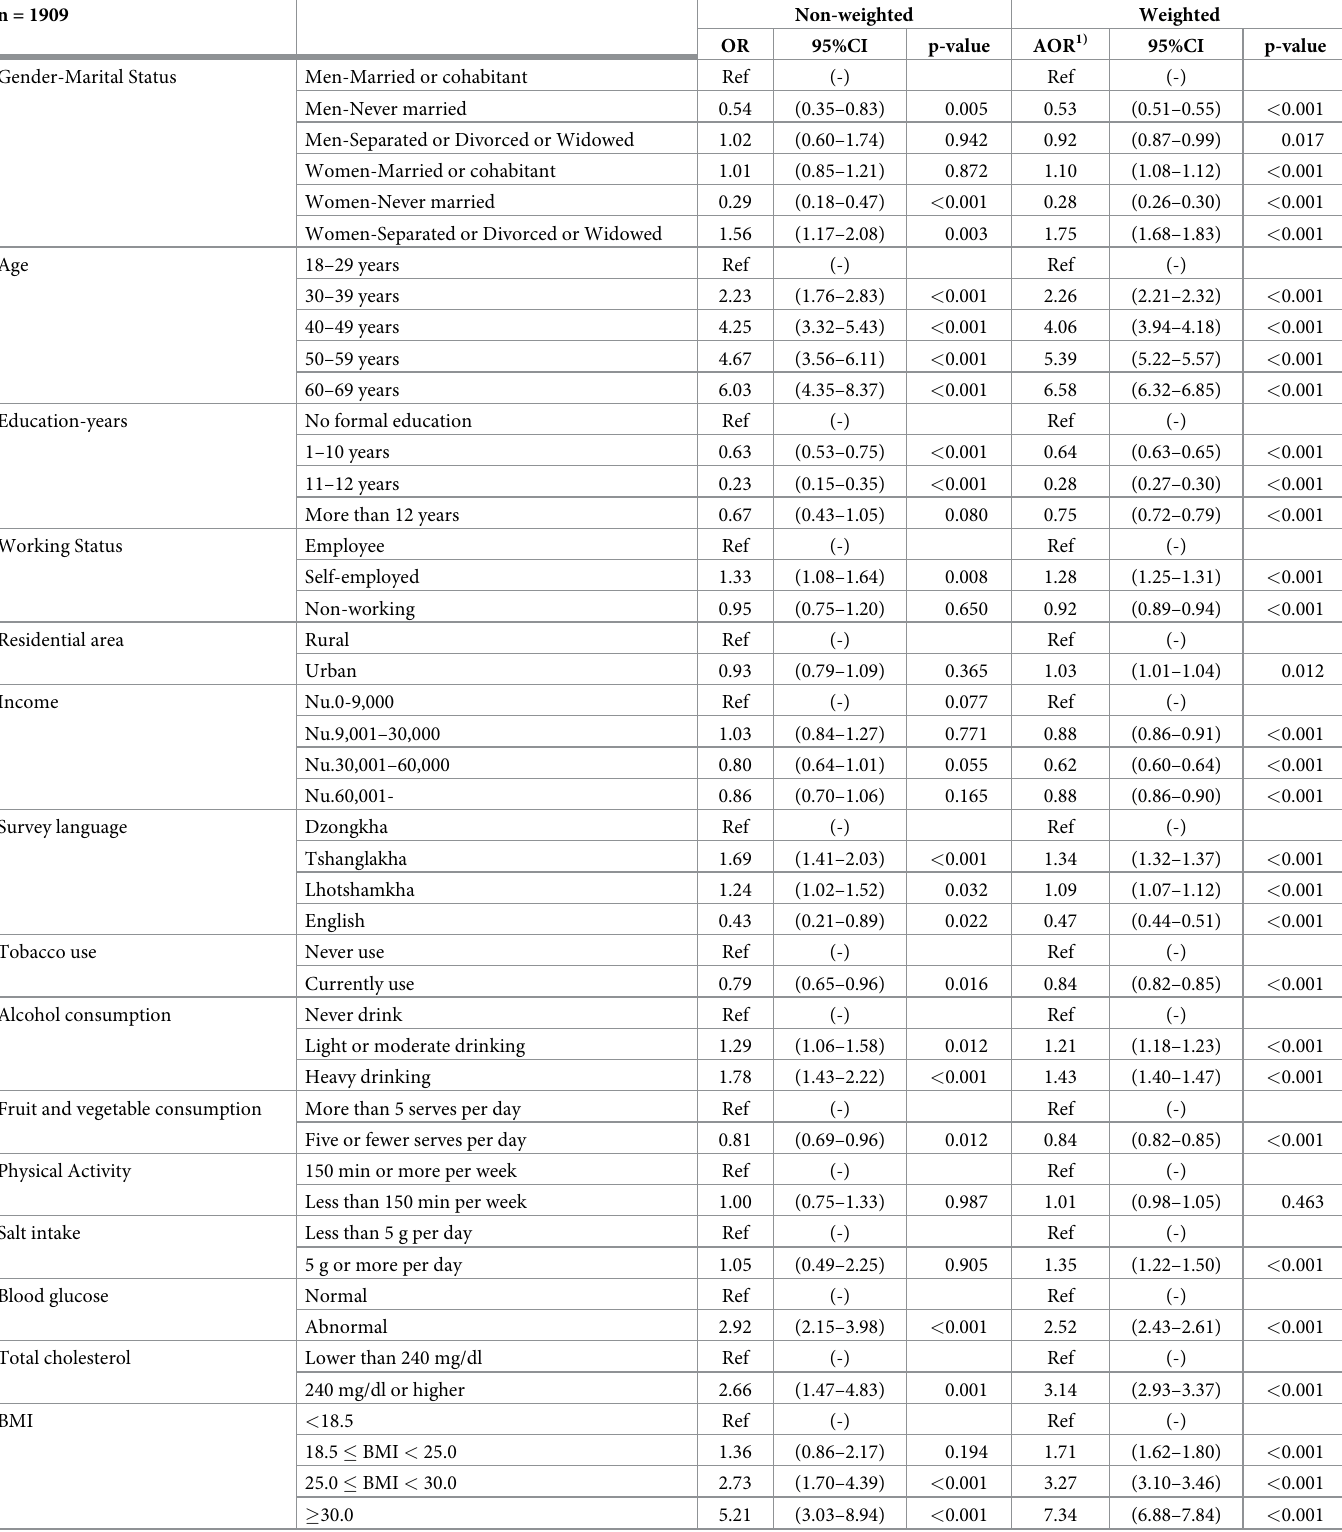
Table 2. Bivariable logistic regression analysis for hypertension with sociocultural, lifestyle, biomedical, and mental health variables (n = 1,909). n =